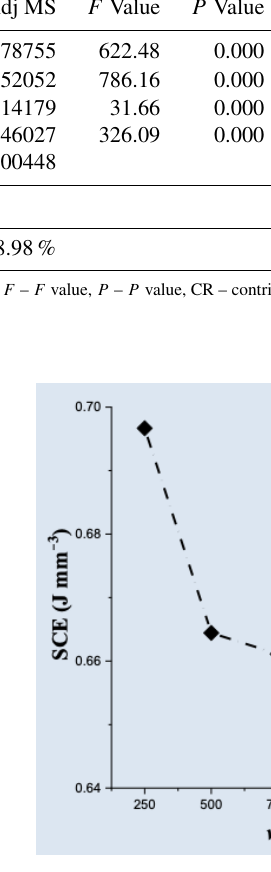
Figure 7. SCE relationship with cutting speed (data from Warsi et al., 2018).